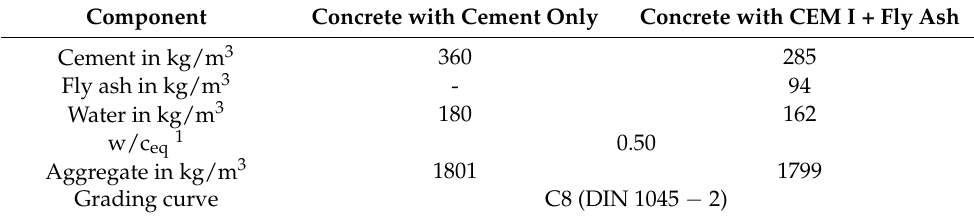
Table 6. Composition of the concrete mixtures (assumed air content: 2 vol%). Component Concrete with Cement Only Concrete with CEM I + Fly Ash Cement in kg/m 3 360 285 Fly ash in kg/m 3 - 94 Water in kg/m 3 180 162 w/c eq 1 0.50 Aggregate in kg/m 3 1801 1799 Grading